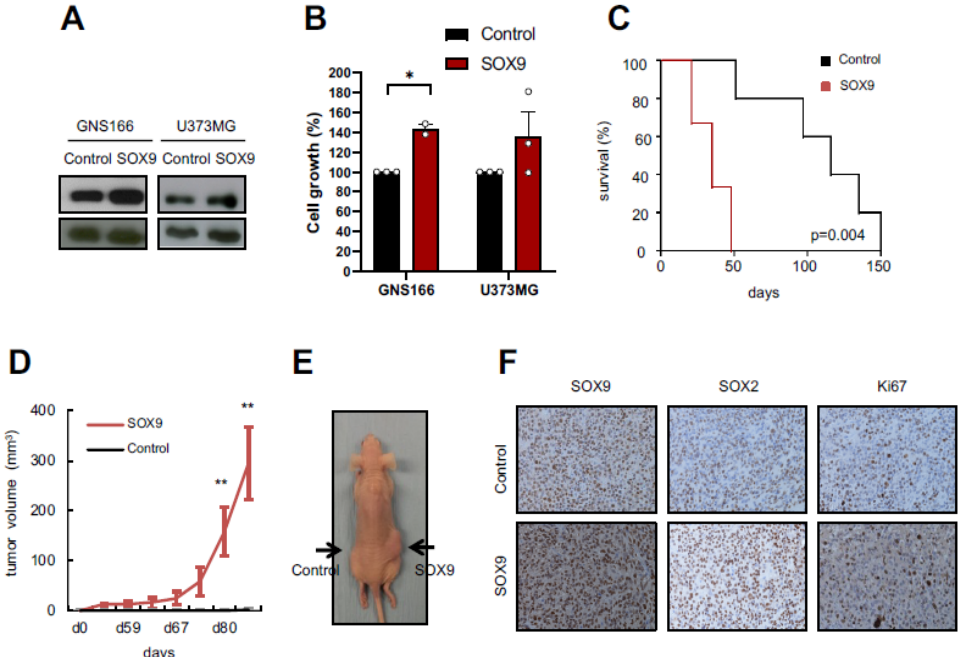
Figure 2. SOX9 upregulation leads to increased tumorigenicity : ( A ) representative immunoblot of SOX9 expression in indicated glioma cells infected with pWXL GFP (“Control” ) and pWPXL-Sox9 (“SOX9”) plasmids. β -actin was used as loading control; ( B ) quantification of cell growth in control and SOX9 overexpression in U373-MG and GNS166 cells at day 5; ( C ) Kaplan–Meier curves repre- senting NOD-SCID mice survival after stereotactic injection of GNS166 control and SOX9 GNS166 cells ( n = 4).; ( D ) tumor volume at indicated time points after subcutaneous injection of control and SOX9 U373-MG cells in immunodeficient mice ( n = 4); ( E ) representative image of tumors in both flanks (right flank: injection of SOX9-overexpressed cells; left flank: control cells). Tumors are indi- cated by arrows; ( F ) representative images of SOX9, SOX2, and Ki67 IHC staining from subcutane- ously generated tumors in “Control” and “SOX9” groups. Scale bar corresponds to 100 µm. * p < 0.05, ** p < 0.01.